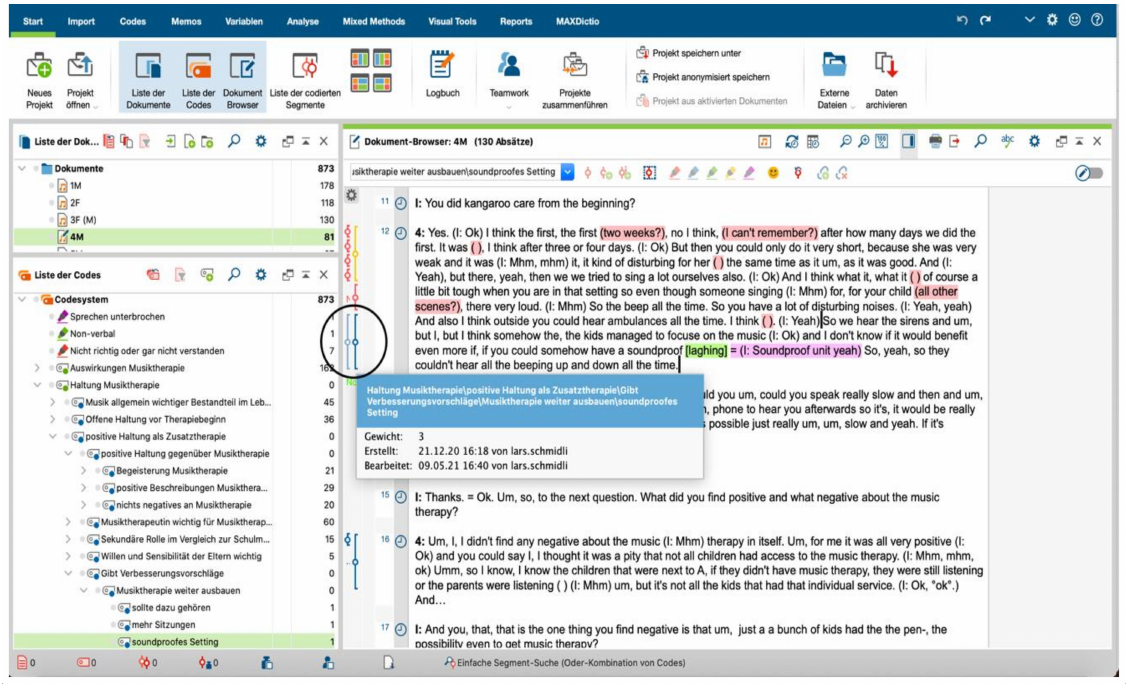
Figure A1. Screenshot of MAXQDA 2020